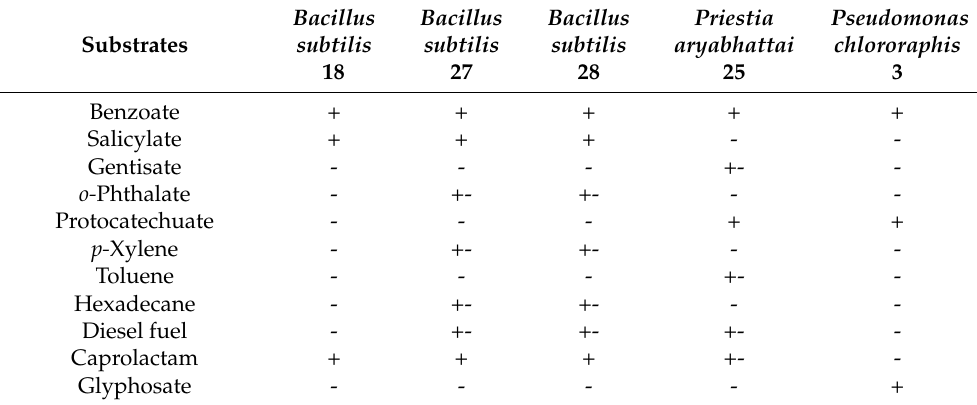
Table 5. Growth of soil strains on toxic organic